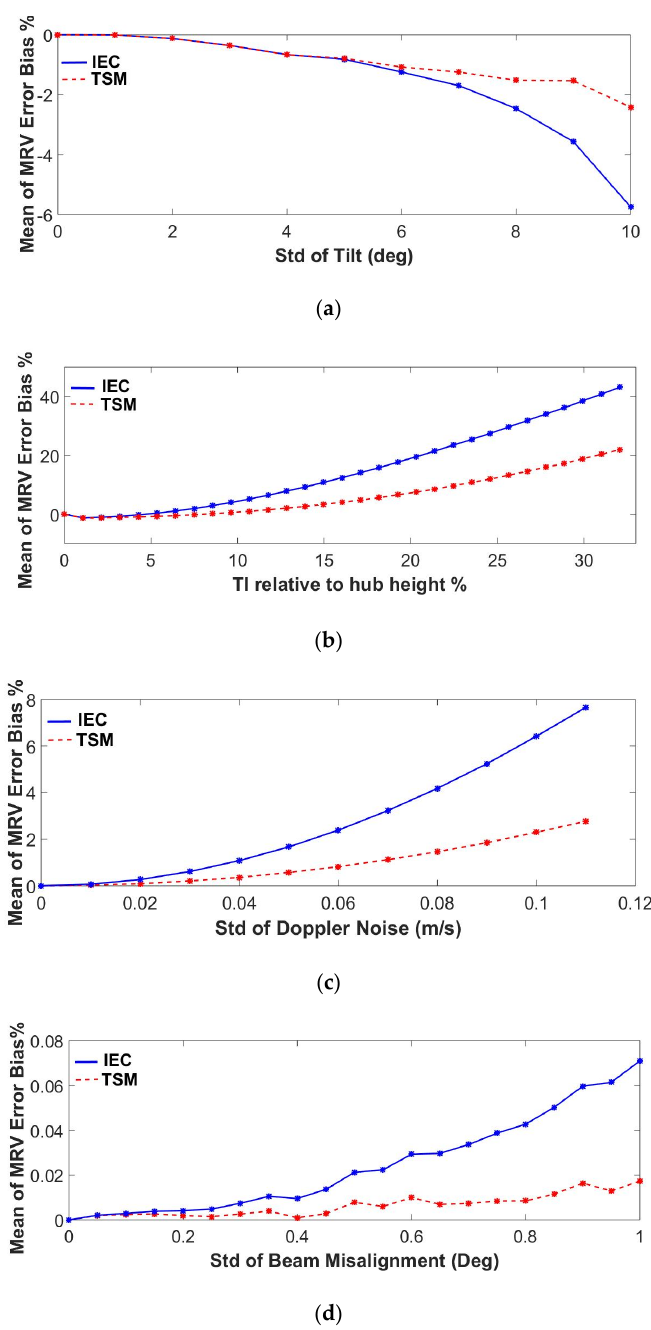
Figure 7. Sensitivity study for error bias of mean of the MRV based on the TSM and the IEC method due to ( a )tilt; ( b ) Turbulence intensity; ( c ) Doppler noise; ( d ) Beam misalignment. Here, MRV: Mean Representative Velocity, IEC: International Electrotechnical Commission and TSM: Temporal-Spatial Method.